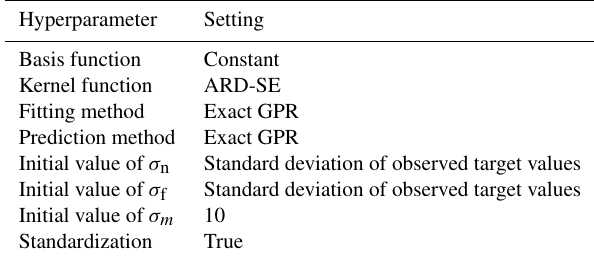
Figure 7. Fitted curves of the estimated coherence between the lidar wind speeds measured at different range gates. The range gates R 1 to R 5 are located at 54.5, 81.75, 109, 136.25, and 163.5m, respec- tively. 1 D = 27.25m. The mean lidar wind speed U l ranges from 7.3 to 7.7ms − 1 , and the lidar-measured turbulence intensity I T , l ranges from 0.10 to 0.12, for different range gates. Date and time: 7 December 2013 at 12:00–12:30. Data source: Lidar Complex. Table 4. Initial settings of GPR model